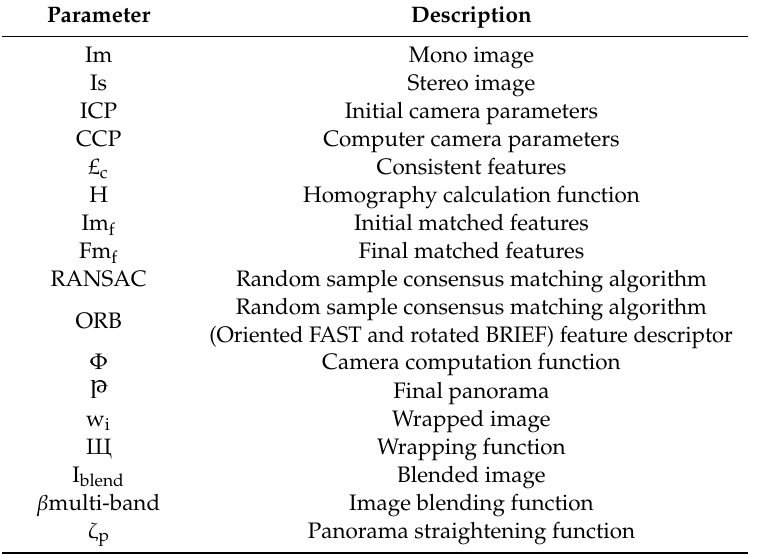
Table 1. Descriptions of parameters, used for input and output operations in our proposed